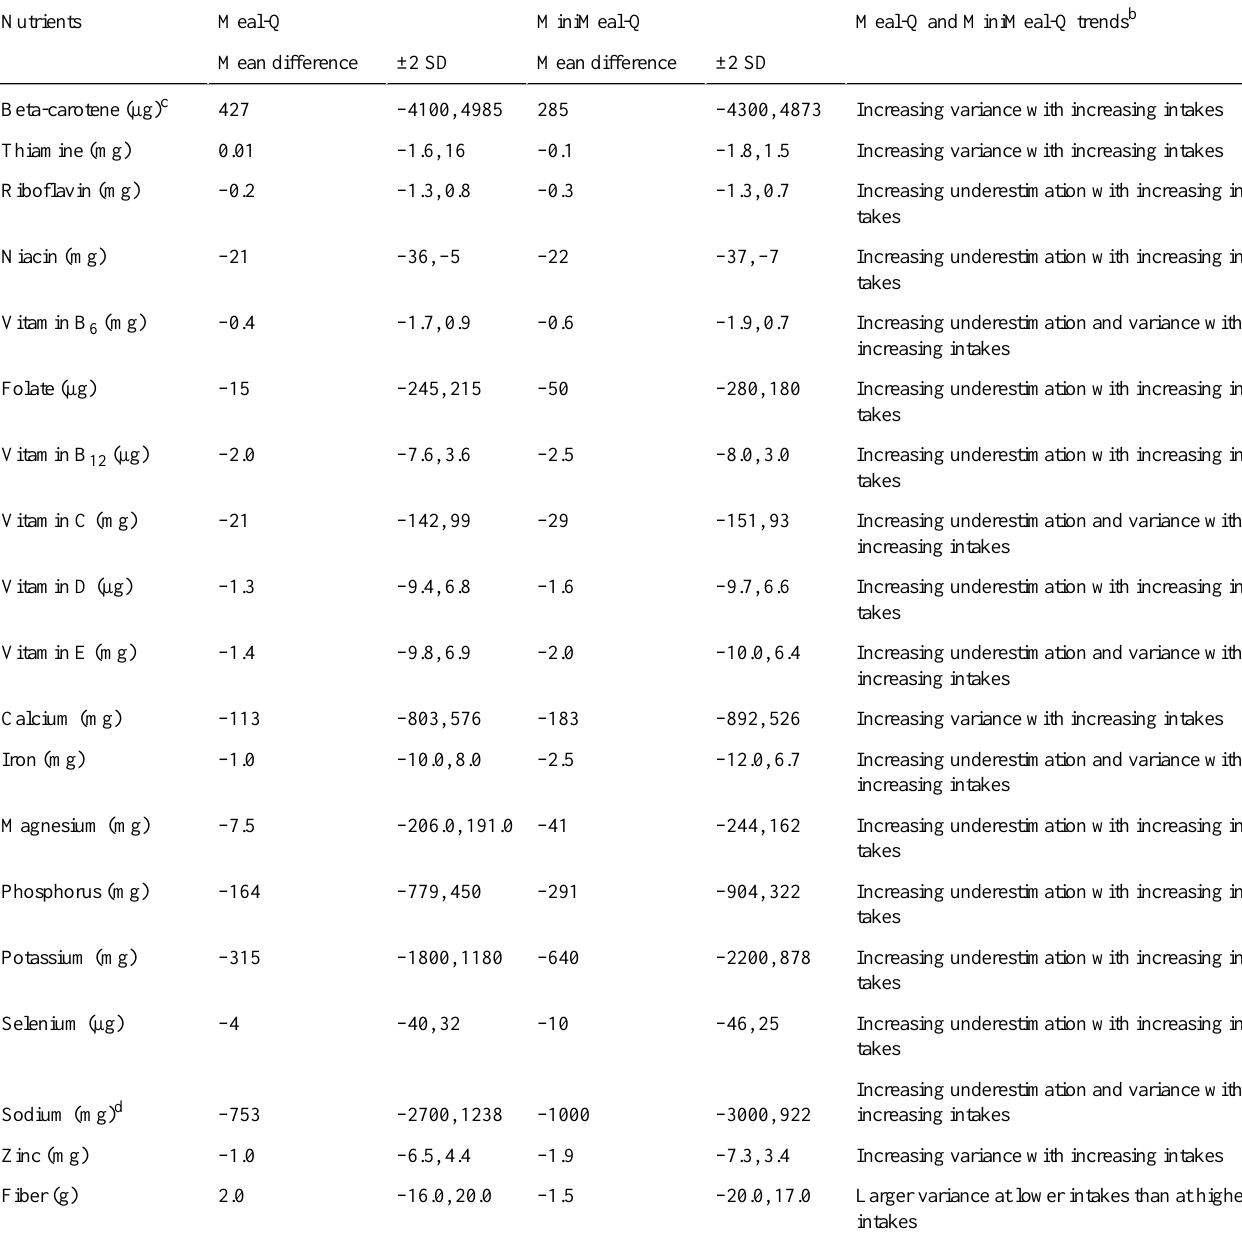
Table 4. Overview of results from Bland-Altman plots a of Meal-Q and MiniMeal-Q in comparison with the weighed food record (WFR)